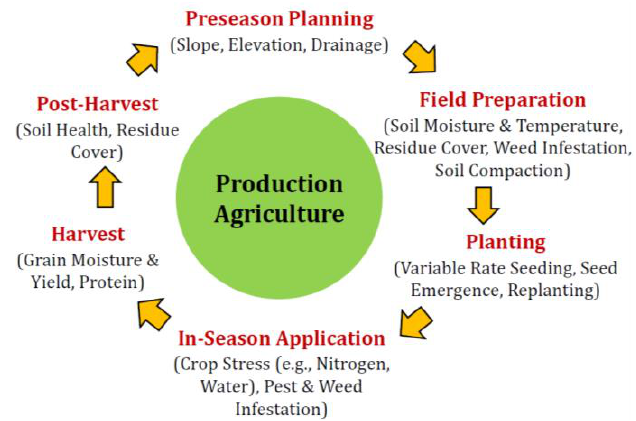
Figure 4. Stages of production agriculture.